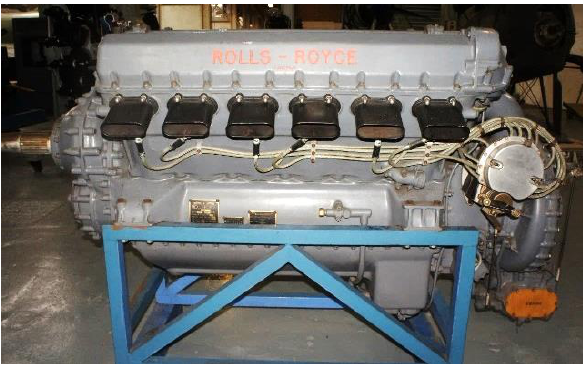
Fig. 4. The Rolls-Royce Merlin engine with centrifugal compressor (Royal Museum of Army and Military History, Brussels, photos by the author)